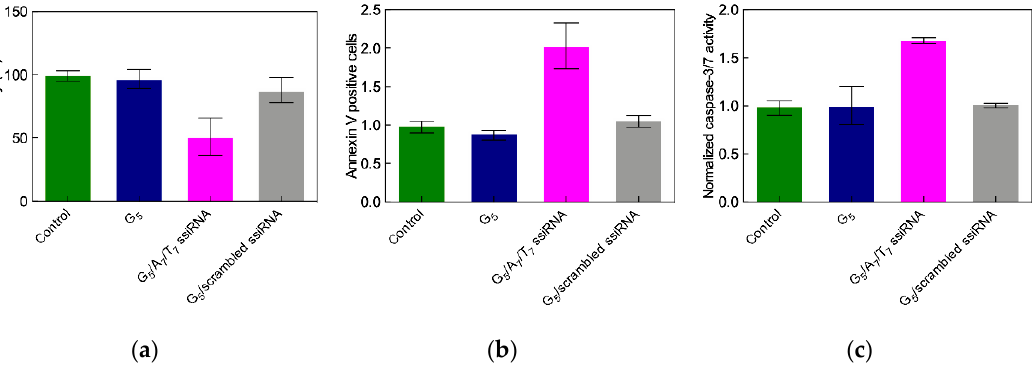
Figure 17. ( a ) Cell proliferation, ( b ) apoptosis, and ( c ) caspase 3/7 activity in PC-3 cells treated with A 7 /T 7 ssiRNAs (50 nM) delivered by G 5 TEA-core PAMAM (N/P = 10). Non-treated cells, the G 5 dendrimer alone and a scrambled (non-silencing) ssiRNA sequence were used for control. Data in panels ( a ) and ( c ) were measured as described in Figure 6. The apoptotic index was measured with fluorescence-activated cell sorting (FACS) flow cytometry by the annexin V assay four days after treatment. Redrawn from [56], with permission of the American Chemical Society.